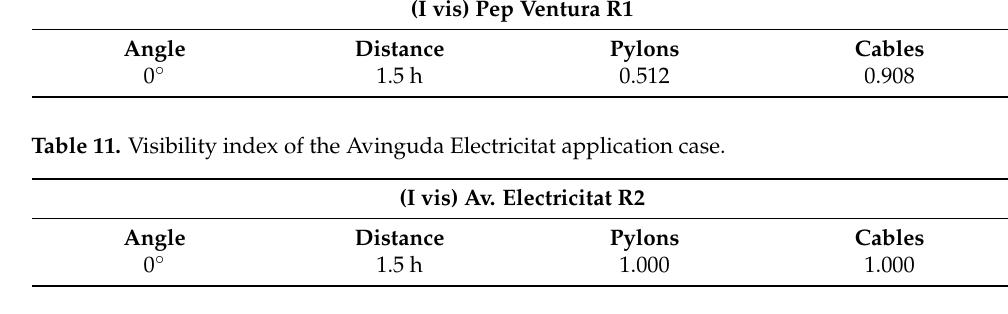
Table 12. Visibility index of the Can Fatj ó application